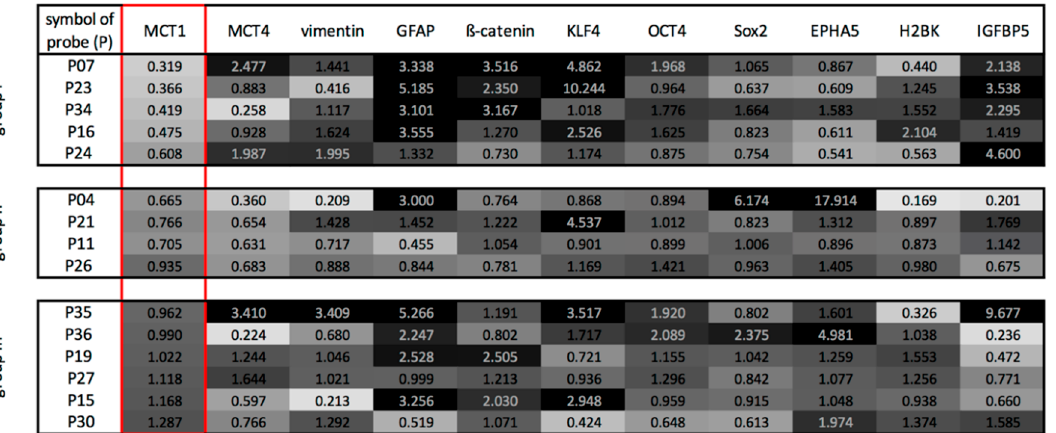
Figure 4. Heatmap-like analysis of gene expression ratios (calculated as 2 − ( ∆ C t cedge − ∆ C t center) ) between pairs of the edge and center glioblastoma samples equal expression at the edge and center pairs is assigned as 30% grey, lower expressions at the edge of the tumor is assigned an increasing lighter shading with a ratio close to 0 corresponding to white, and higher expressions at the edge of the tumor is assigned with increasing darker grey shades until 3 or higher-fold expression which is assigned as black. Mainly depending on the n-fold expression changes of MCT1, therefore outlined in red, three groups with distinct patterns of marker expression could be distinguished: group I showing a downregulation of MCT1 combined with an upregulation of GFAP and individual EMT-, stemness- and dormancy-associated markers ( β -catenin, KLF4, IGFBP5) at the edge of the tumor—group II showed a slightly to moderate downregulation of MCT1 and MCT4 at the edge of the tumor, whereas the EMT-, stemness- and dormancy-associated markers were expressed heterogeneously and group III revealed a heterogenous pattern of all examined markers.